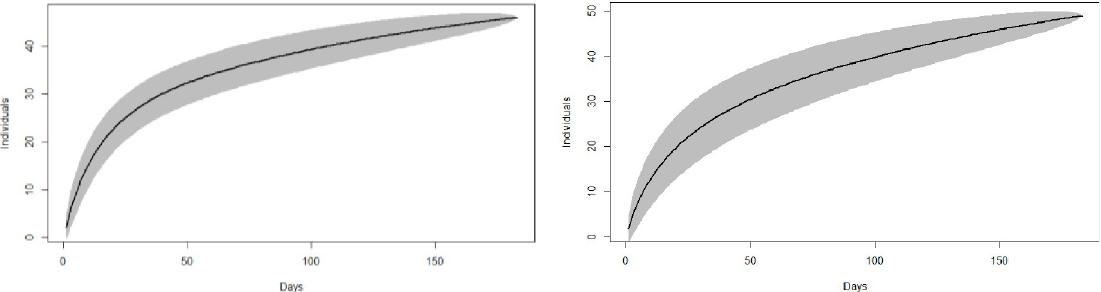
Fig 3. Accumulation curve for individual leopards for summer (left) and winter